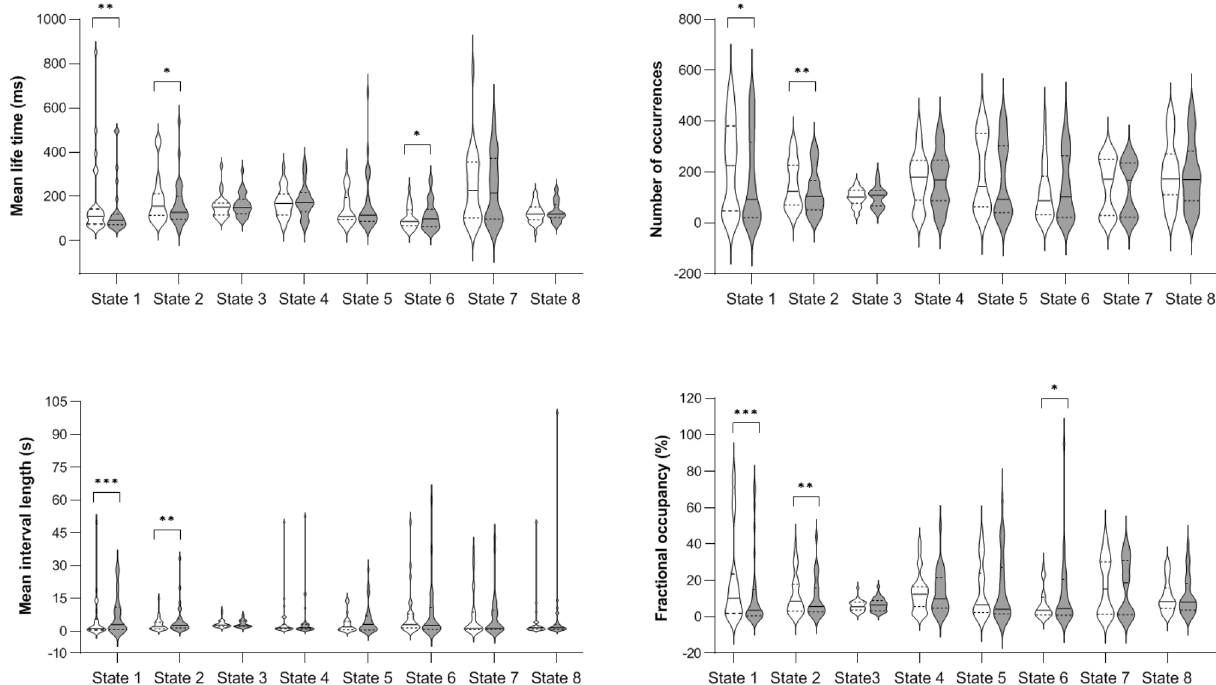
Figure 3. Temporal parameters for HMM states before (Pre, in white) and after (Post, in grey) motor learning [* p < 0.05 (uncorrected); ** p < 0.01 and *** p < 0.001 (corrected for 7 independent states)]. Violin plots are shown with the median as a solid line and quartiles as dotted lines. The figure was created in GraphPad Prism version 9.1.2 for Windows, GraphPad Software, San Diego, California USA, www. graph pad.